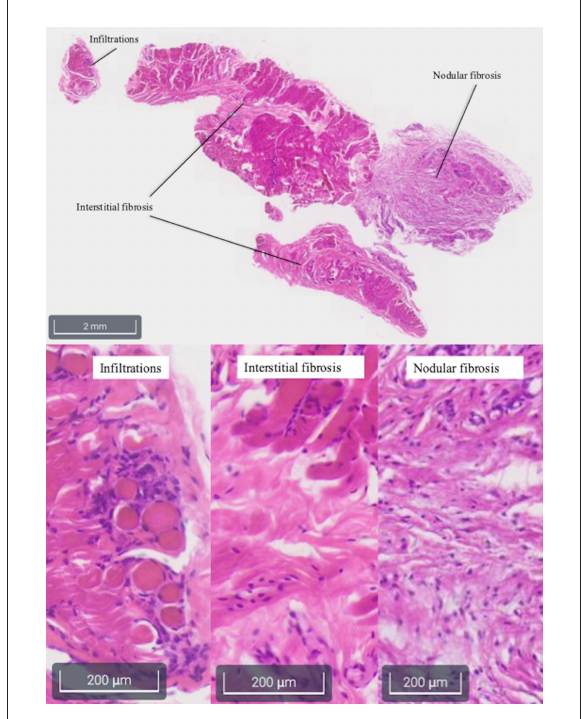
FIGURE4 Photomicrograph of histological, hematoxylin and eosin stained, section of a temporalis muscle of a 5-month old Cavalier King Charles Spaniel affected by masticatory muscle myositis. Note the inflammatory infiltration and the interstitial and nodular fibrosis of the temporalis